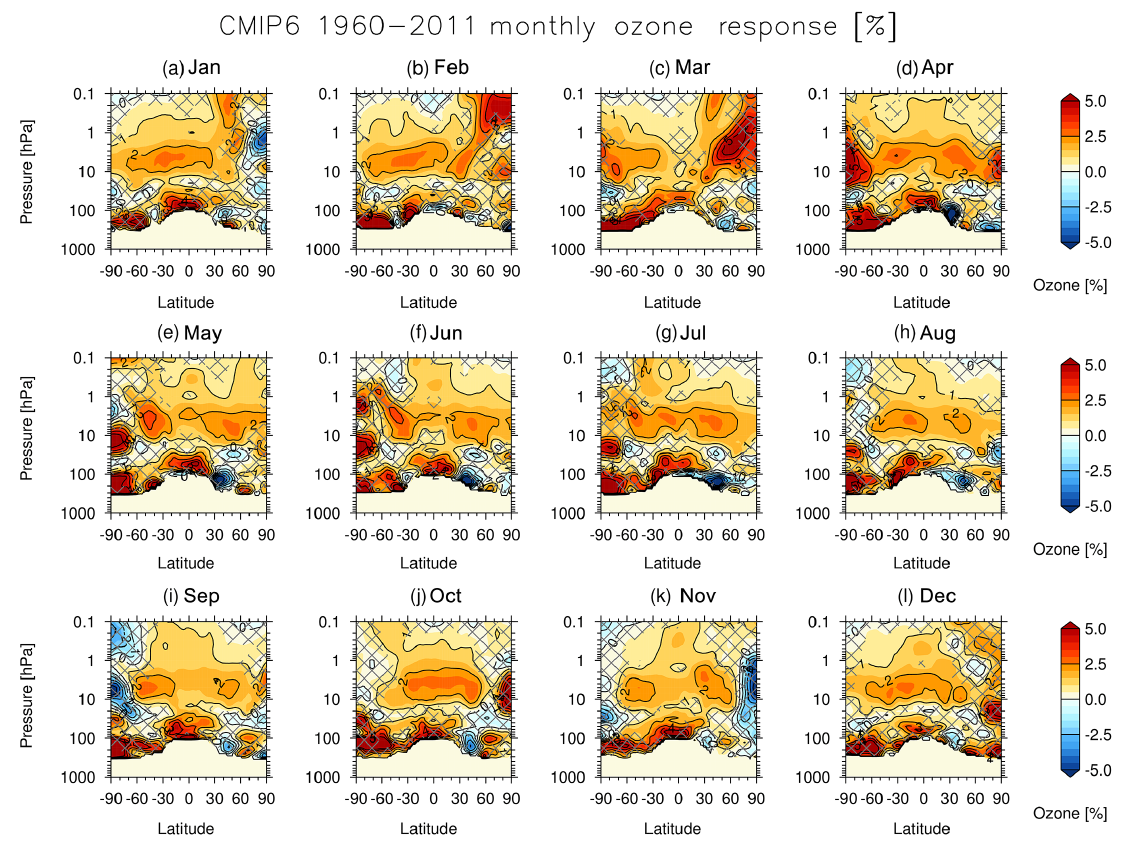
Figure 27. A preliminary estimate of the fractional (%) monthly solar-ozone response per 130 units of the F10.7 so- lar flux in the CMIP6 ozone database for the period 1960–2011 diagnosed using the ozone mixing ratio files downloaded from http://esgf-node.llnl.gov/projects/input4mips (vmro3_input4MIPs_ozone_CMIP_UReading-CCMI-1-0_gr_195001-199912.nc and vmro3_input4MIPs_ozone_CMIP_UReading-CCMI-1-0_gr_200001-201412.nc). The hatching denotes regions where the solar-ozone re- sponse, diagnosed using multiple regression analysis, is found to be not significantly different from zero at the 95% confidence level. Please note that the CMIP6 ozone database for the future simulations was not released at the time of writing. Adapted from Maycock et al.